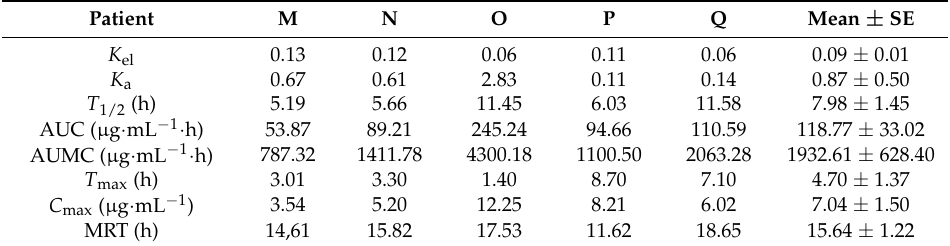
Table 4. Pharmacokinetic parameter estimates of melatonin in Group-3.